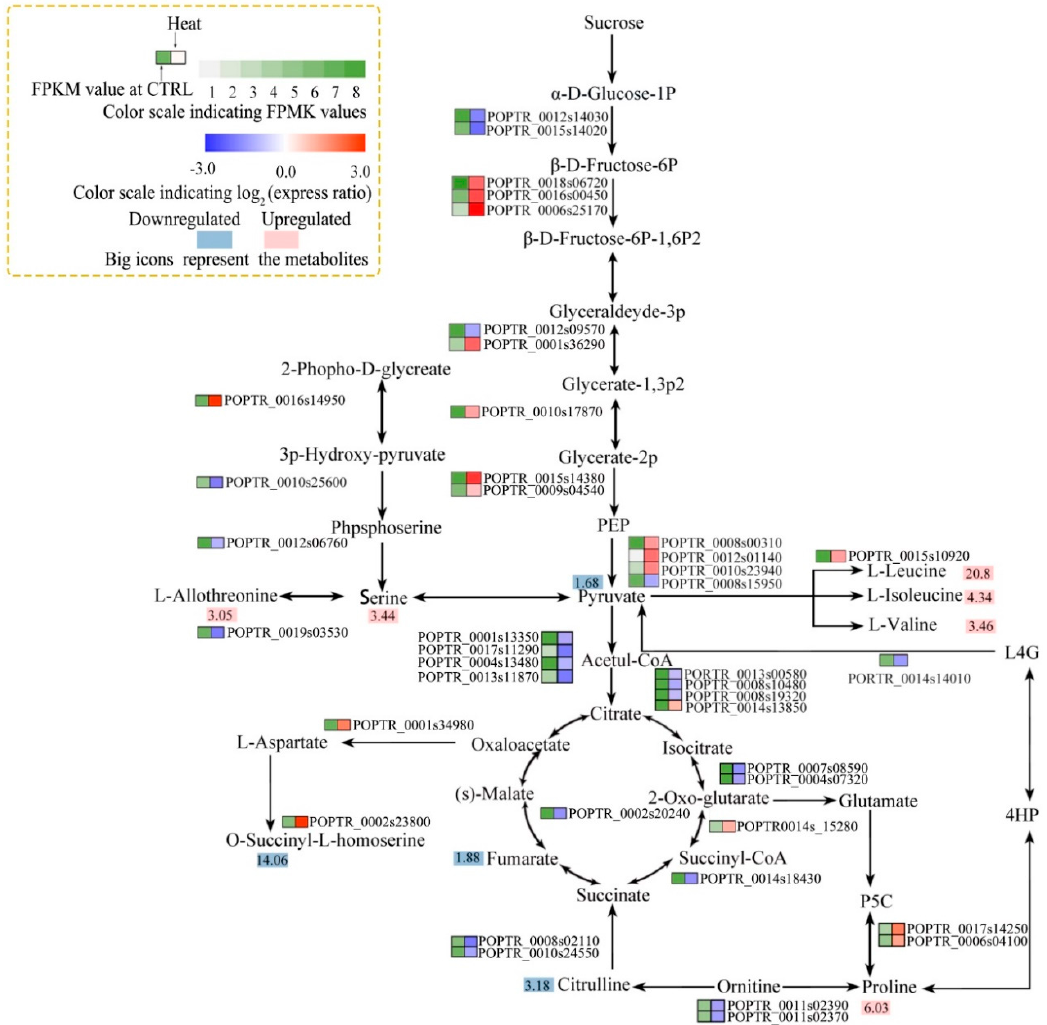
Figure 7. Associated pathway analysis of metabolite levels and enzyme activities. Arginine and proline biosynthesis metabolism; glycine, serine, and threonine metabolism; glycolysis / gluconeogenesis; citrate cycle (TCA); and valine, leucine, and isoleucine biosynthesis pathways. Metabolites whose levels did not differ were omitted. Colors at right indicate the log 2 expression ratio [log 2 (heat / control_ mean)], and at left, the FPKM value of the control. (Levels 1–8, FPKM values of 0–10, 10–20, 20–40, 40–80, 80–160, 160–320, 320–640, and 640 + , respectively). Large icons, metabolites; red, upregulation; blue, downregulation.